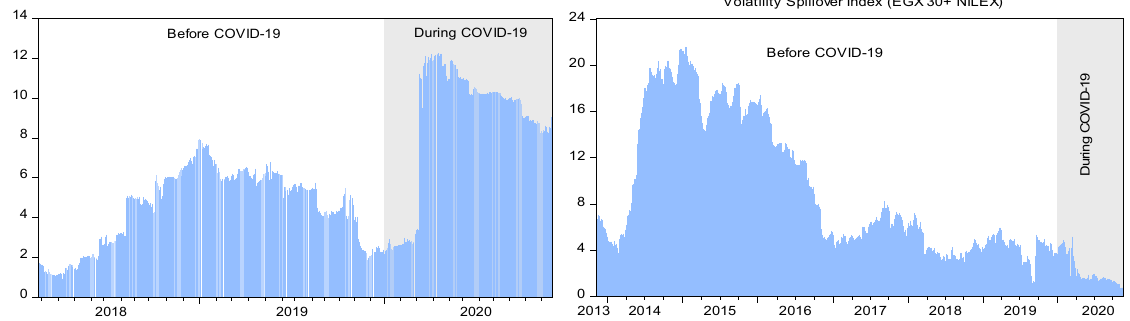
Figure 3. Dynamic total volatility spillover indices based on the Diebold and Yılmaz (2014) framework. Notes: Dynamic spillover indices are calculated from the forecast error variance decompositions on 10-step-ahead forecasts. The total spillover indices are estimated by using 200-day rolling windows for the full sample period. TASI (NOMU) denotes the Saudi main stock market index (SME stock market index). EGX30 (NILEX) denotes the Egyptian main stock market index (SME stock market index).